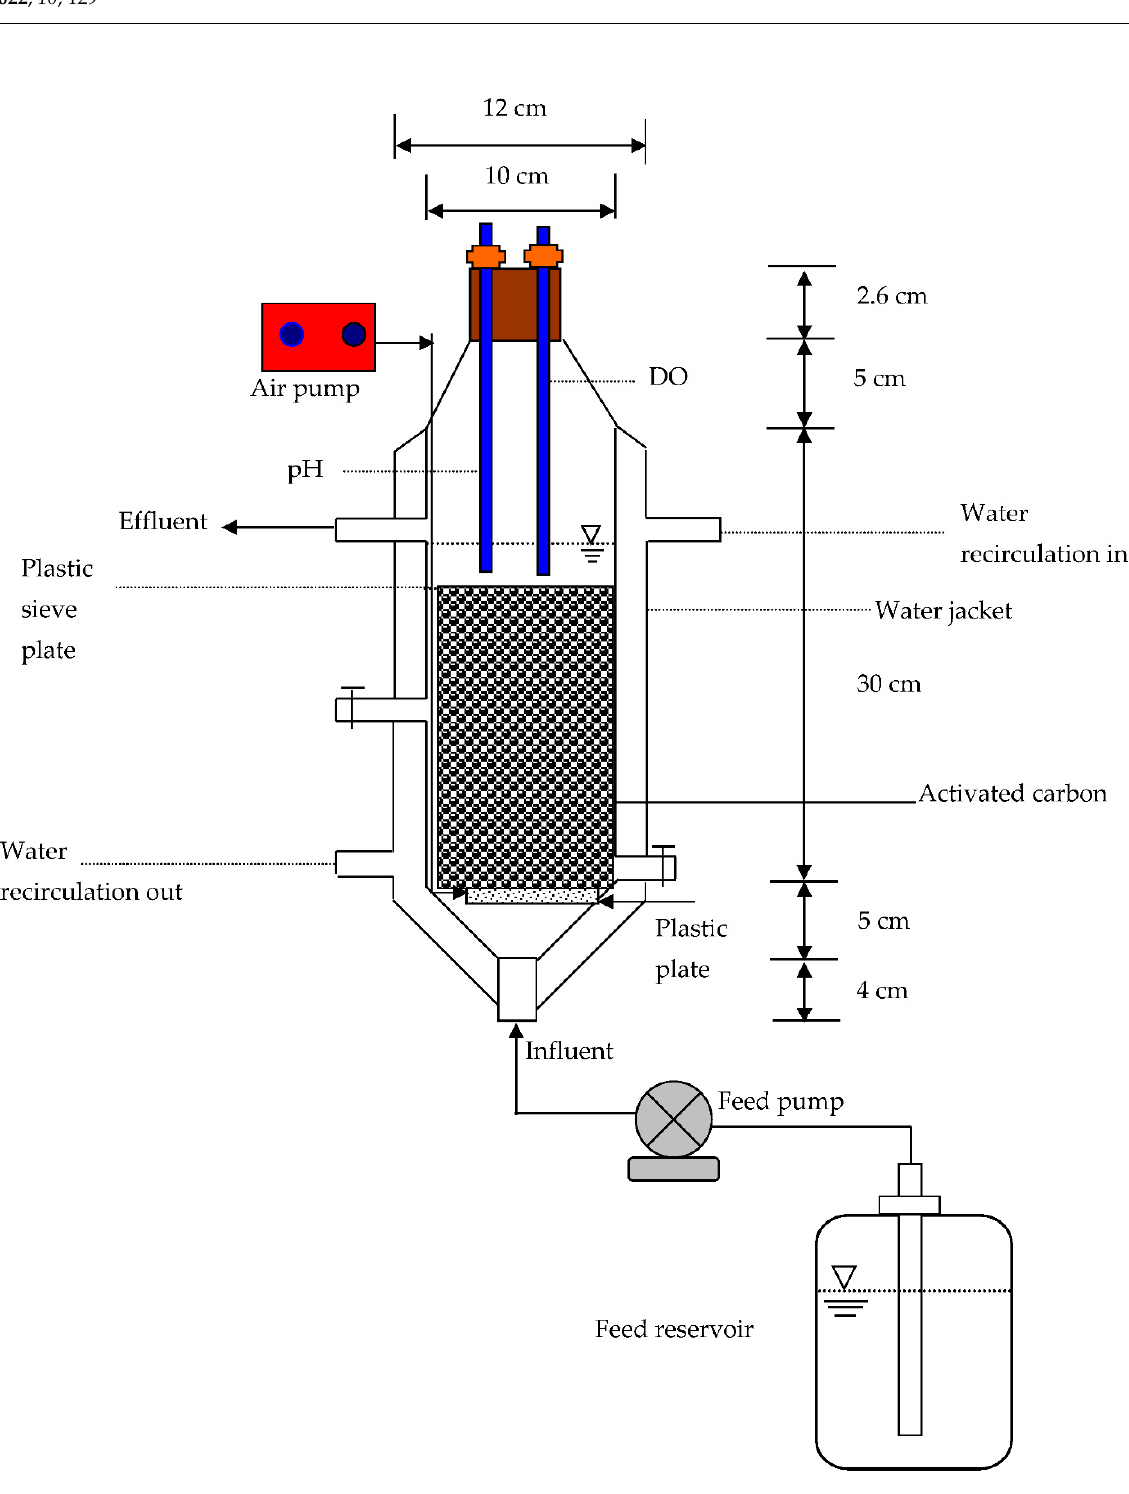
Figure 1. Schematic diagram of the biological activated carbon (BAC) reactor set ‐ up.